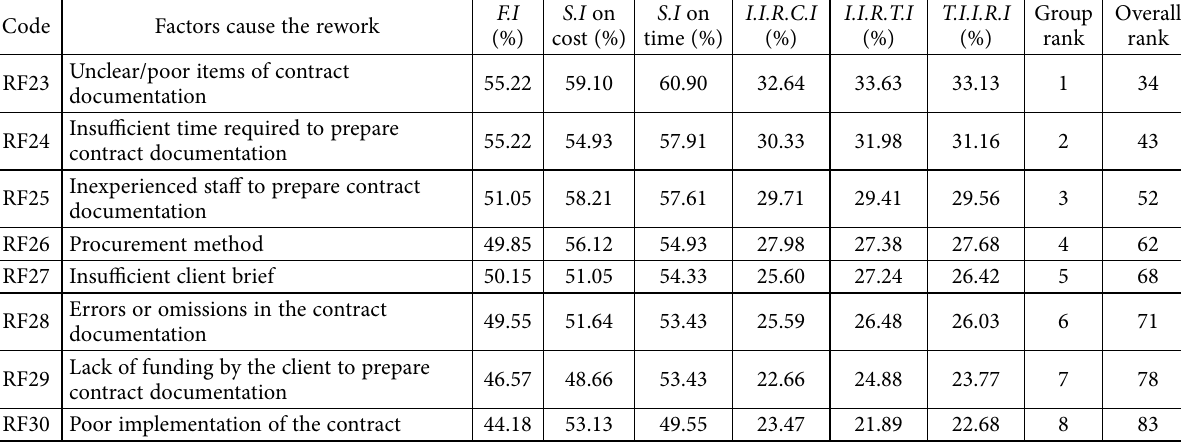
Table 6. Ranking the causes and impact of rework factors related to the